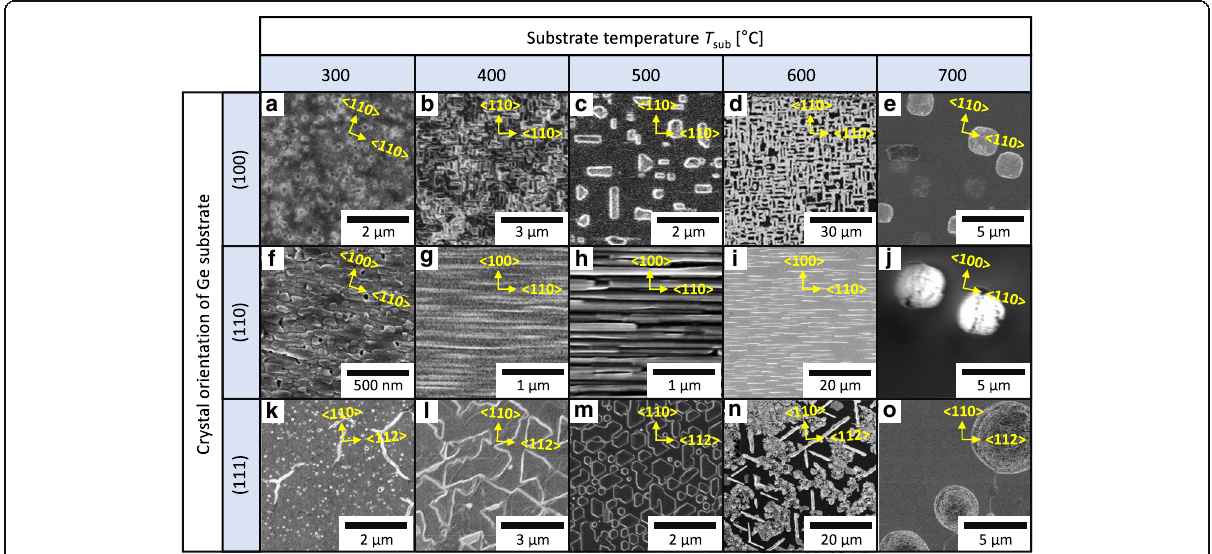
Fig. 2 SEM images of the samples after the Sr deposition. The crystal orientation of the Ge substrate is a − e (100), f − j , (110), and k − o (111). T sub is ranged from 300 to 700 °C for each substrate. The arrows in each image show the crystal directions of the Ge substrates